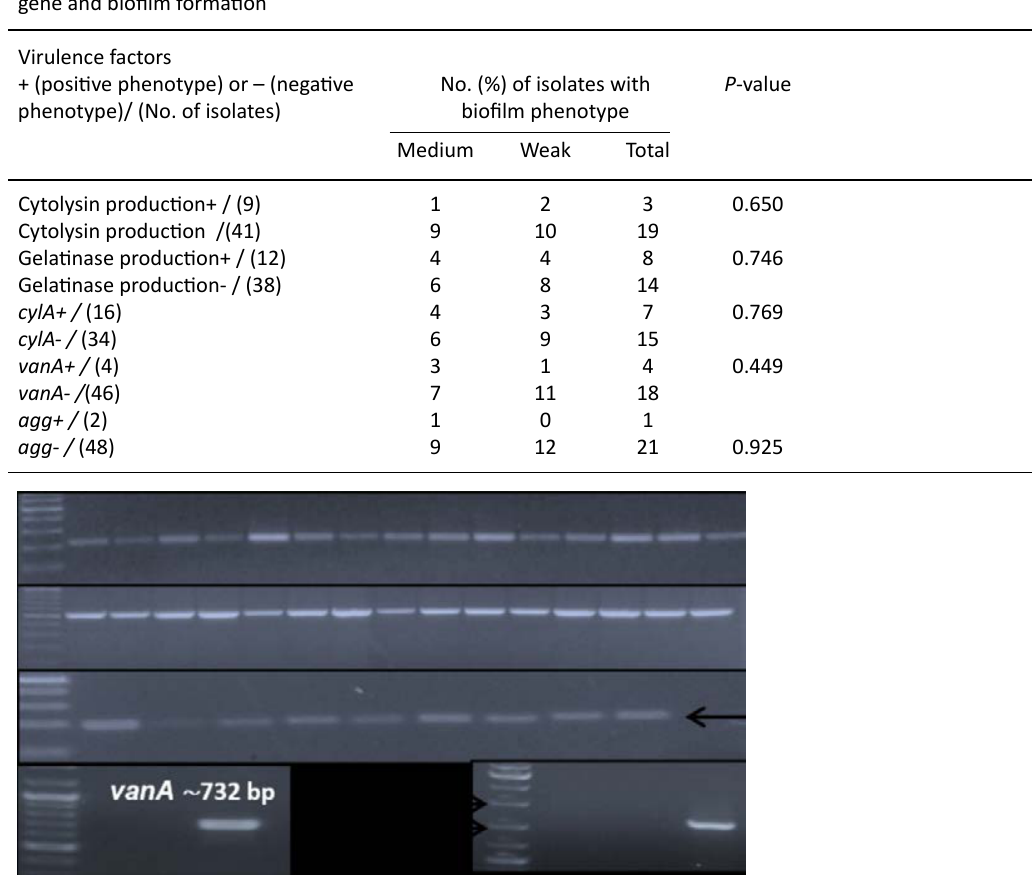
Fig. 2. Representative agarose gel (1%) electrophoresis of PCR products of investigated plasmid-carried antimicrobial resistance and virulence factors encoding genes among enterococcal